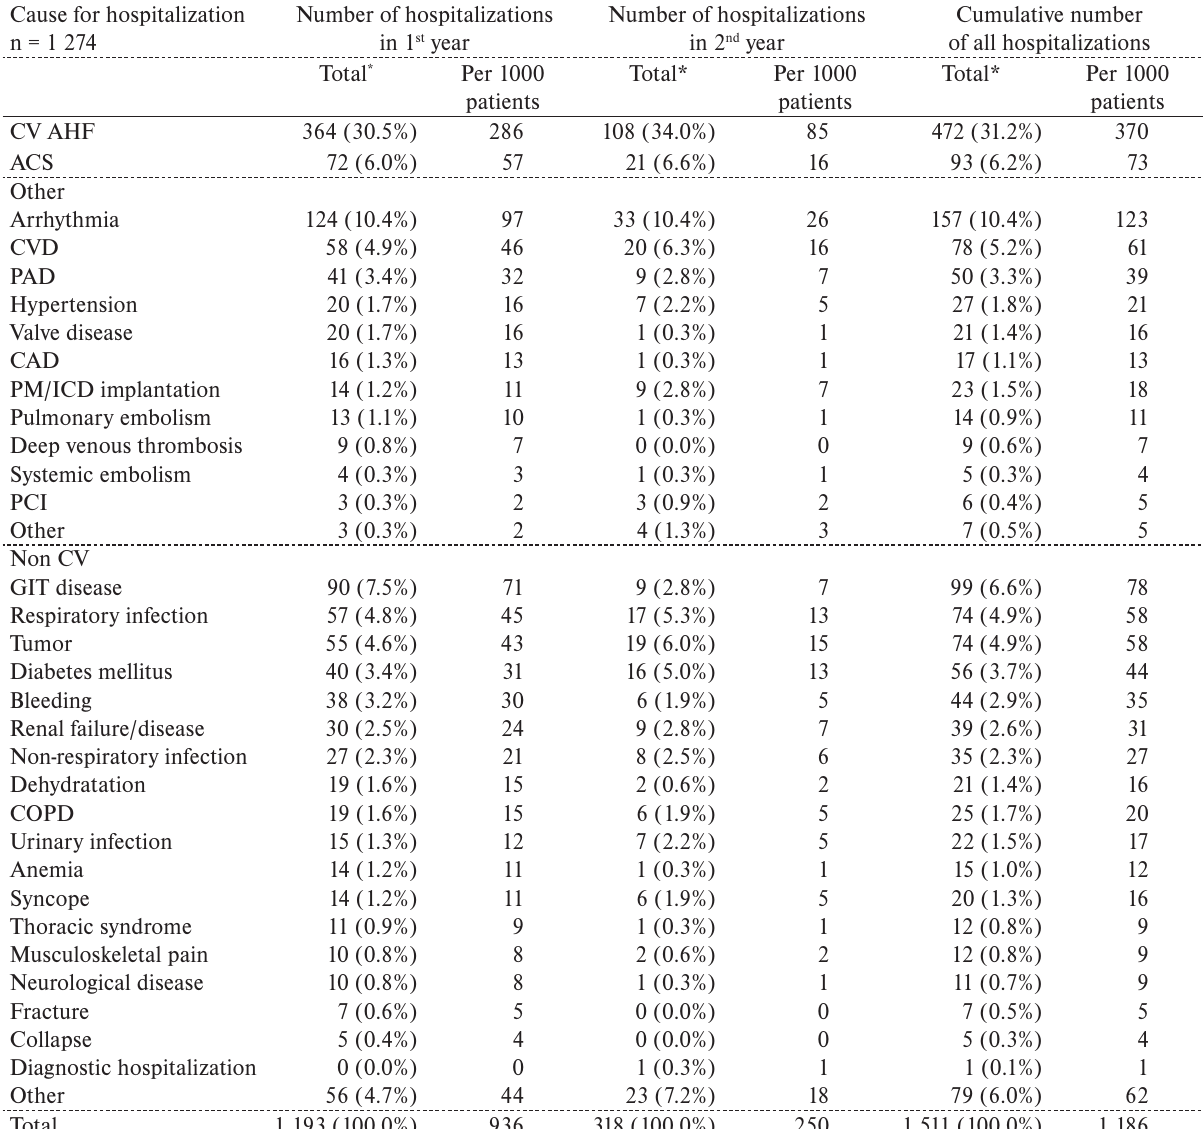
Table 3. The causes for hospitalizations during the first and the second year of follow-up and cumulative summary of all events during the follow-up period of 2 years after index hospital